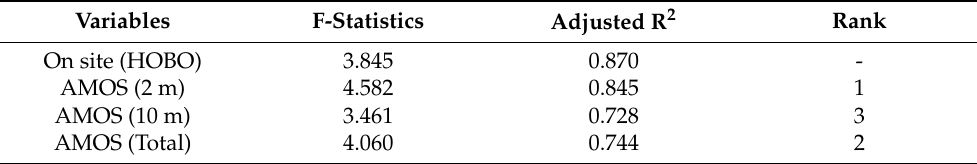
Table 5. Results of regression analysis for selecting AMOS